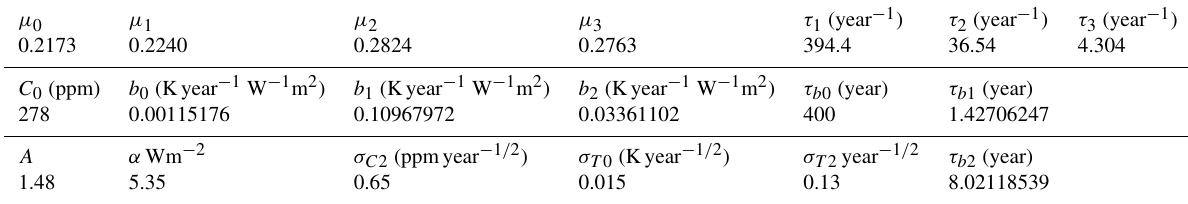
Table 2. Stochastic state-space model parameters. All timescales are in years, the carbon model amplitudes µ i are dimensionless for E in (ppmyear − 1 ) and the temperature model amplitudes b i are in (Kyear − 1 W − 1 m 2